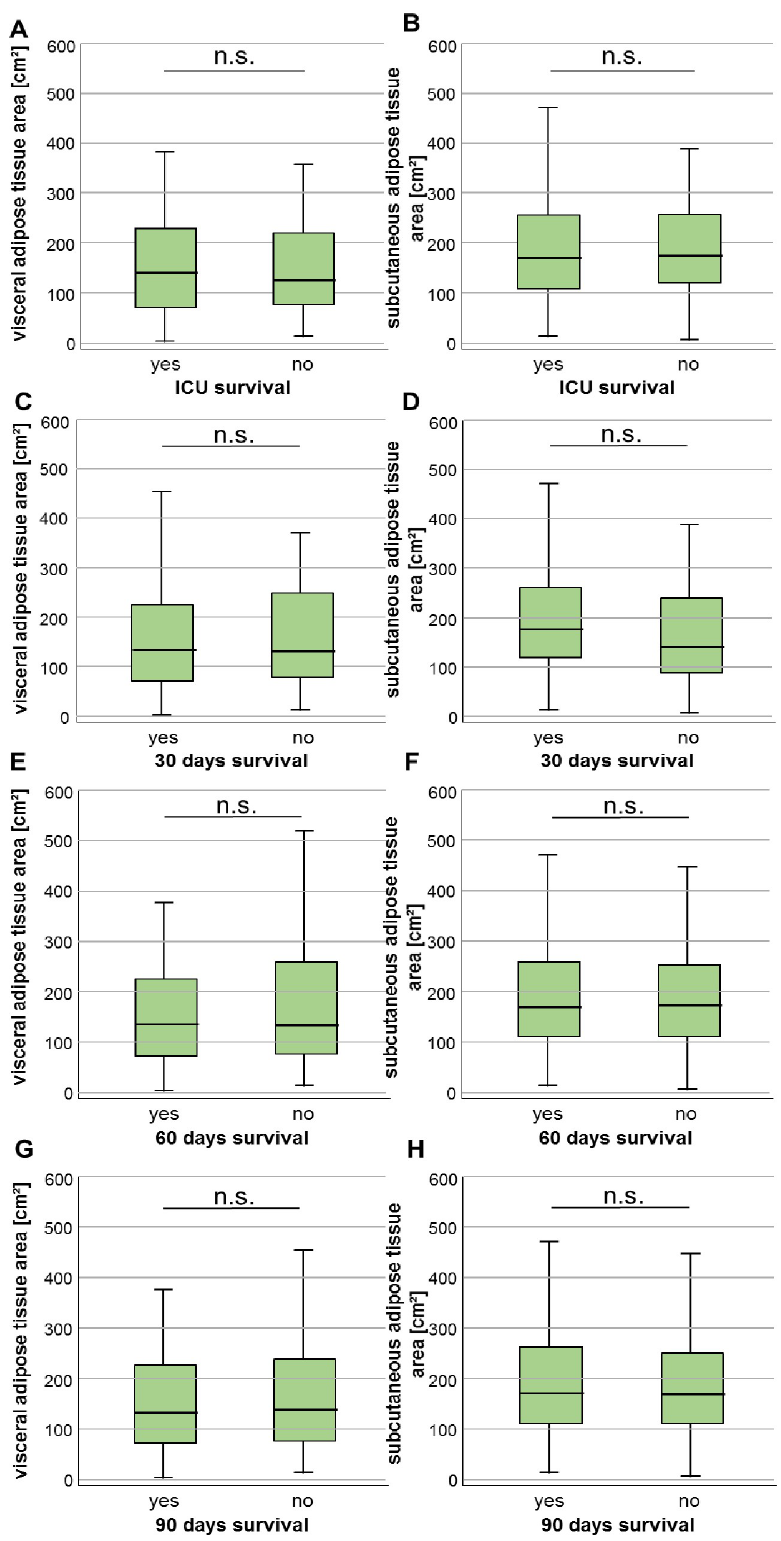
Fig 5. Neither the VAT nor SAT area predicts short-term survival in critically ill patients. (A, B) Patients who survive the ICU stay have similar VAT as well as SAT areas compared to ICU non-survivors. Both tissue areas